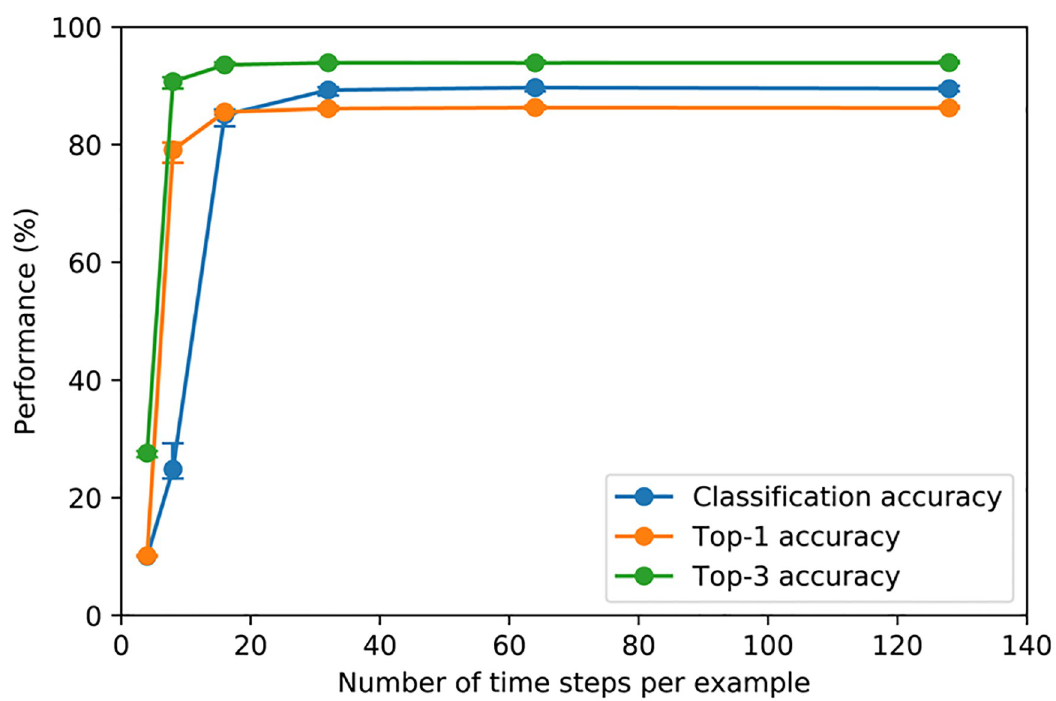
Fig 4. Tradeoff between performance metrics and number of time